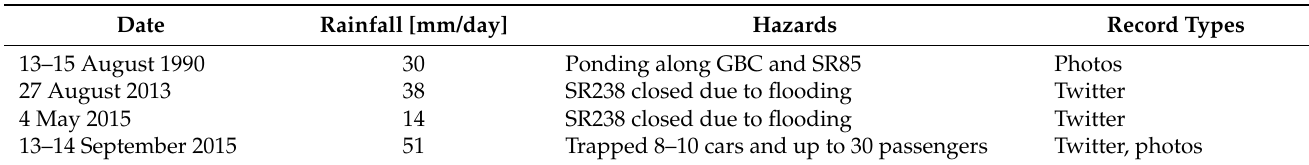
Table 1. Flood history events in the town of Gila Bend, Arizona.